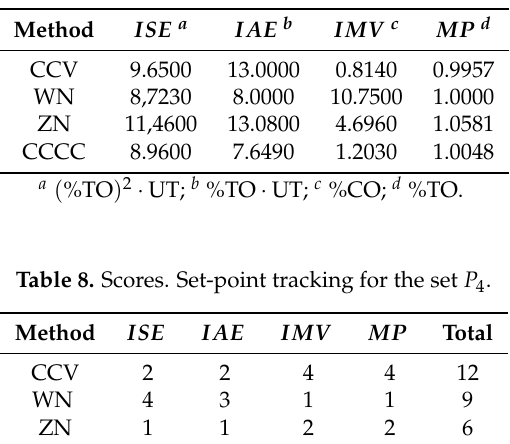
Table 7. Performance indexes. Set-point tracking for the set P 4 .